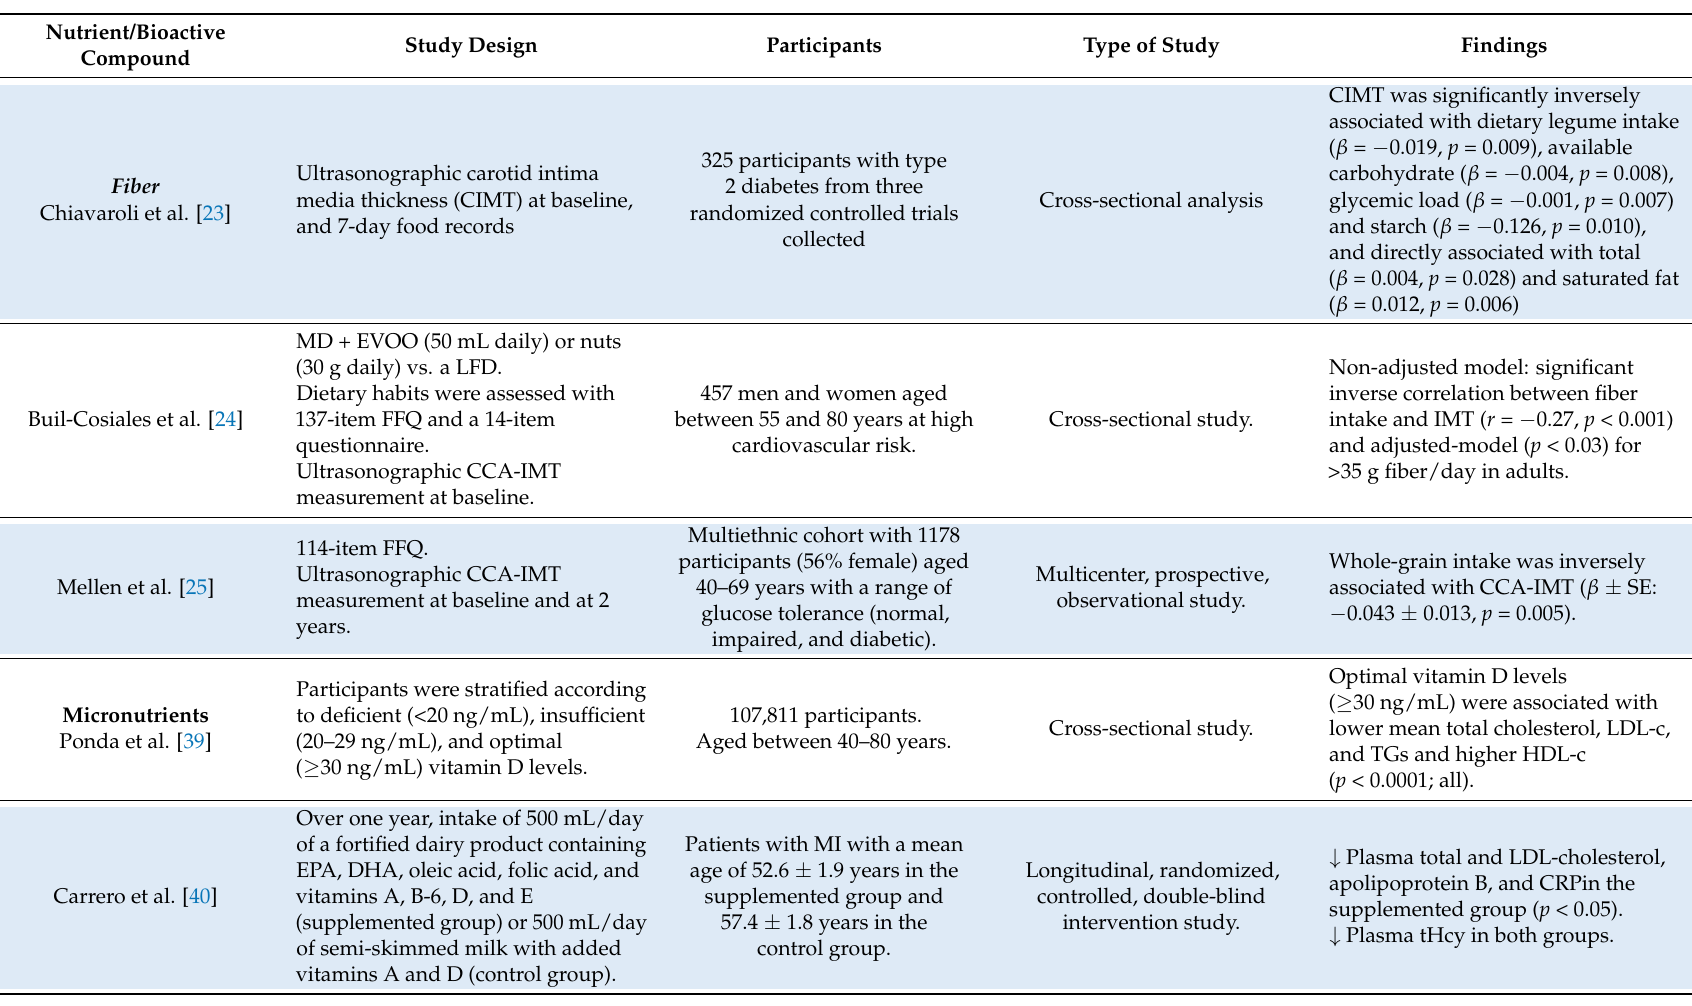
Table 1. Possible mechanisms by which nutrient/bioactive compounds intake can exert a protective effect on the progression of